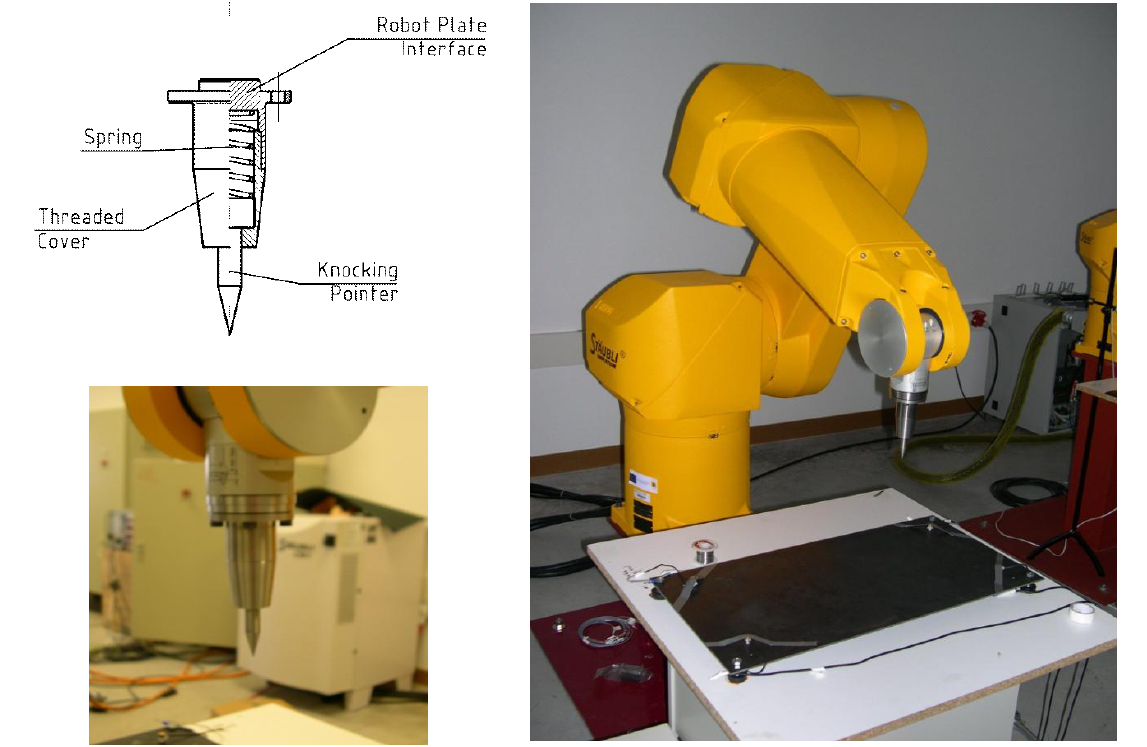
Figure 9. Knocking tool and its integration into the robotized setup.